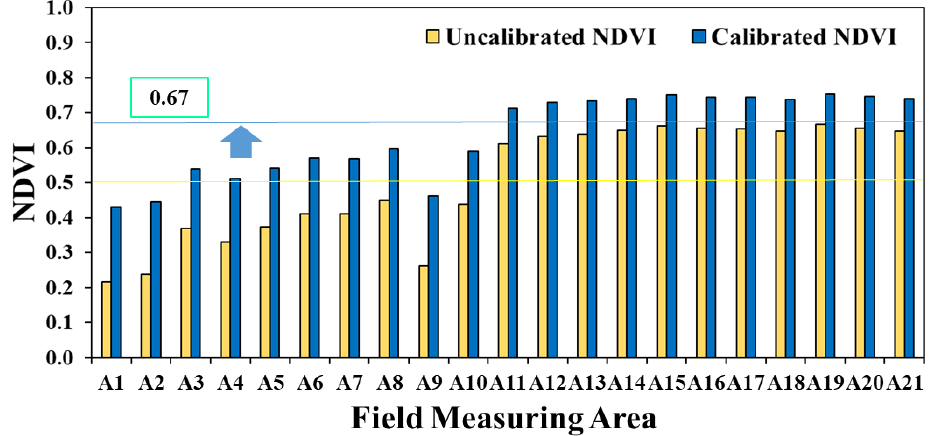
Figure 17. Comparison of UAV imagery NDVI before and after calibration. The yellow line is the boundary value before calibration, and the blue line is the boundary value after calibration.